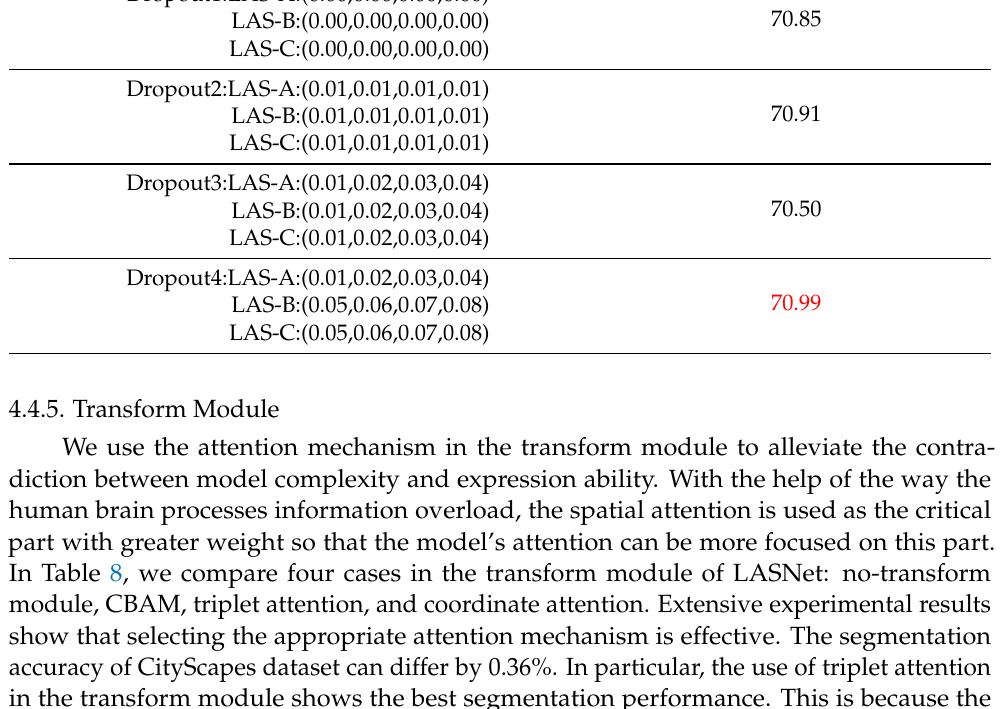
Table 7. Ablation studies of different dropout rates. The red color font indicates the optimal result. Dropout Rates